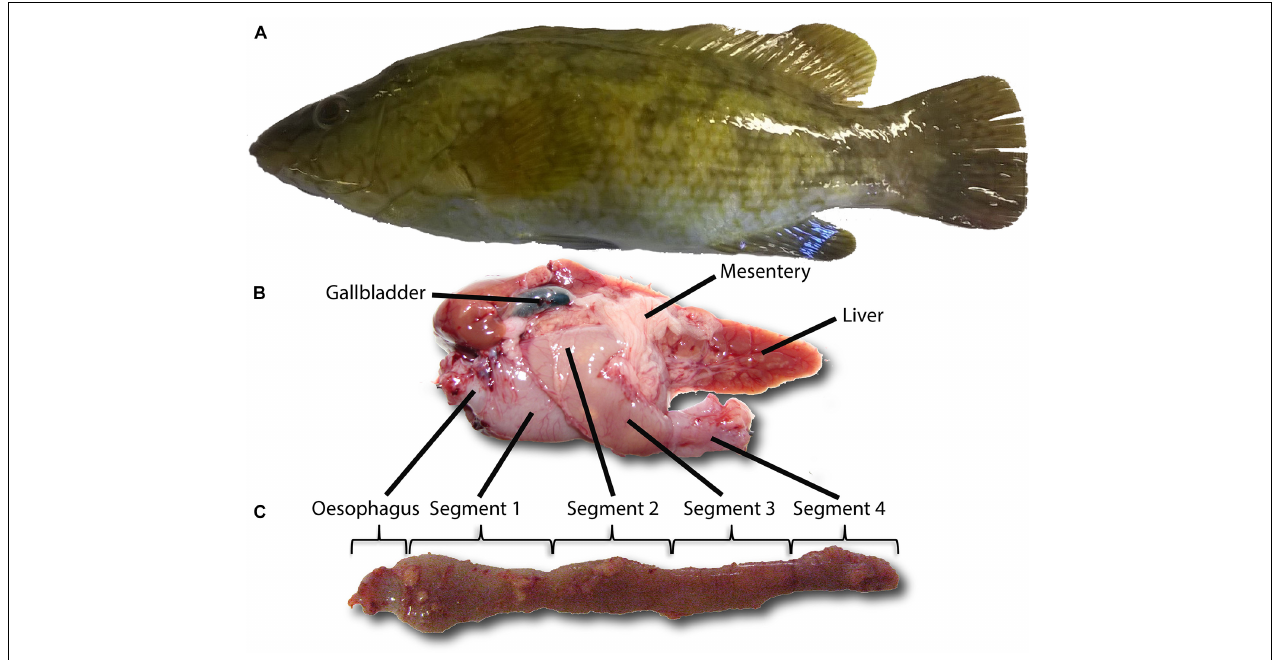
FIGURE 1 | Digestive system of ballan wrasse. Ballan wrasse ( Labrus bergylta ) (A) ; digestive system as found in vivo (B) ; anatomy of the intestine and the division of the intestinal tract into 4 segments (C) , based on Lie et al.